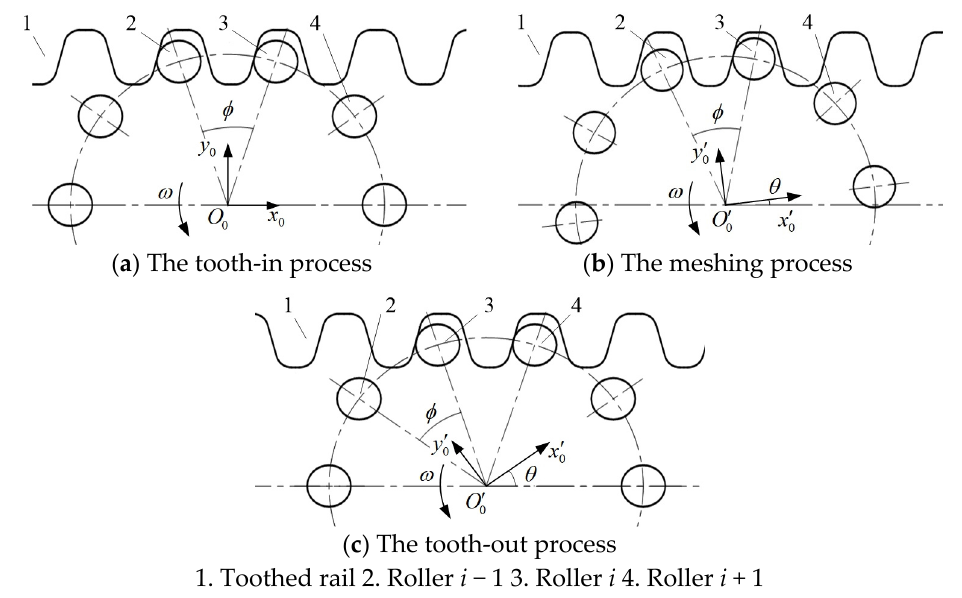
Figure 2. The meshing of the roller gear with a toothed rail.